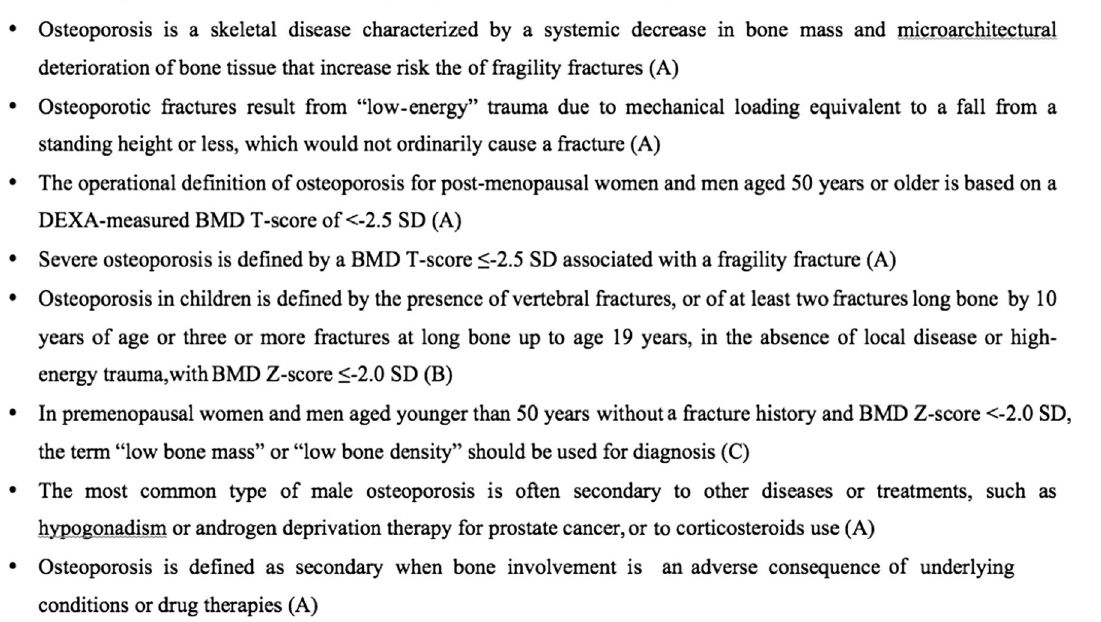
Fig. 1 Toolbox for guidance: definition of